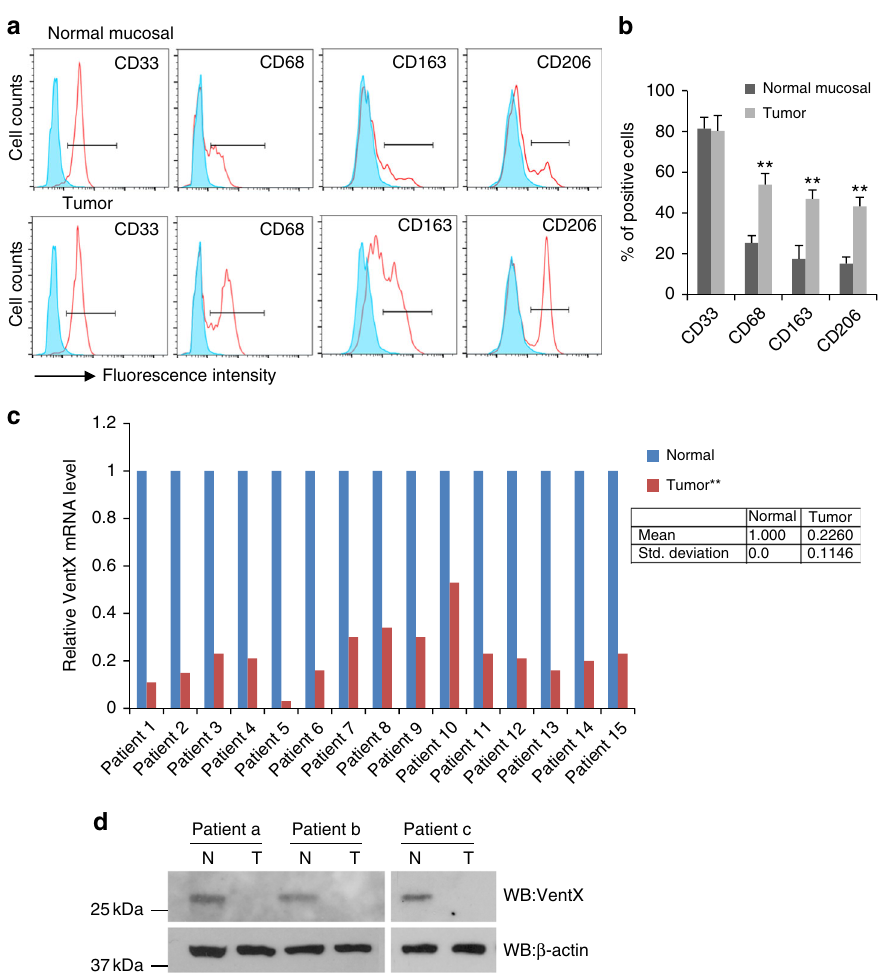
Fig. 1 VentX expression is downregulated in TAMs. a , b FACS analysis and the percentage of surface expression of CD33, CD68, CD163, and CD206 on macrophages isolated from normal mucosa and tumors. Shaded peaks indicated isotope control. Representative fi gures of fi ve independent experiments were shown, n = 5. Error bars represent SD and paired Student ’ s t -test was performed. ** p < 0.01. c Paired comparison of RT-PCR measurement of VentX mRNA expression in macrophages isolated from normal control tissues and TAMs of 15 patients. The relative VentX mRNA expression levels in normal macrophages were arbitrarily designated as 1. Paired Student ’ s t -test was performed, ** p < 0.01 TAMs vs. normal macrophages. Data shown in the box are mean ± SD of 15 patients. d Western blot analysis of endogenous VentX protein levels in macrophages isolated from normal control tissues and TAMs